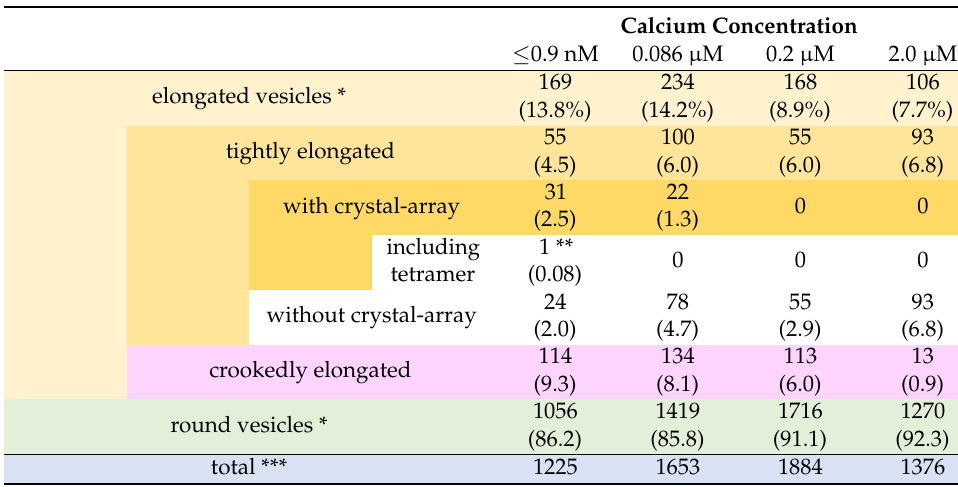
Table 1. Classification of the SR vesicles observed at < 0.09 nM, 0.086, 0.2, and 2.0 µ M Ca 2+ in the presence of ATP. The observed vesicles (major axis > 0.065 µ m) were classified as the elongated or round types, and then, the elongated vesicles were sub-classified as tightly elongated or crookedly elongated. The tightly elongated vesicles were further classified into the two types ‘with’ and ‘without’ a crystalline array of the 40 Å surface particles. For the analysis, 9–12 TEM images that included one or more tightly elongated vesicle with or without a distinct crystal-array, respectively, were recorded at each calcium concentration (<0.9 nM, 0.086 µ M Ca 2+ , 0.2 µ M Ca 2+ and 2.0 µ M Ca 2+ ). For each concentration, the vesicle populations (56–228 vesicles) within each of the 4.5 µ m by 4.5 µ m regions imaged were subjected to vesicle classification; the resulting data are summarized in the table. The number of each type of vesicle relative to the total number of vesicles (elongated and round), at the respective calcium concentrations is given as a percentage in parenthesis. Yellow, pink and green represent elongated, crookedly elongated and round vesicles, respectively. Cream-, straw- and saffron-yellow represent elongated vesicles, tightly elongated vesicles, and tightly elongated vesicles with a crystal-array, respectively.